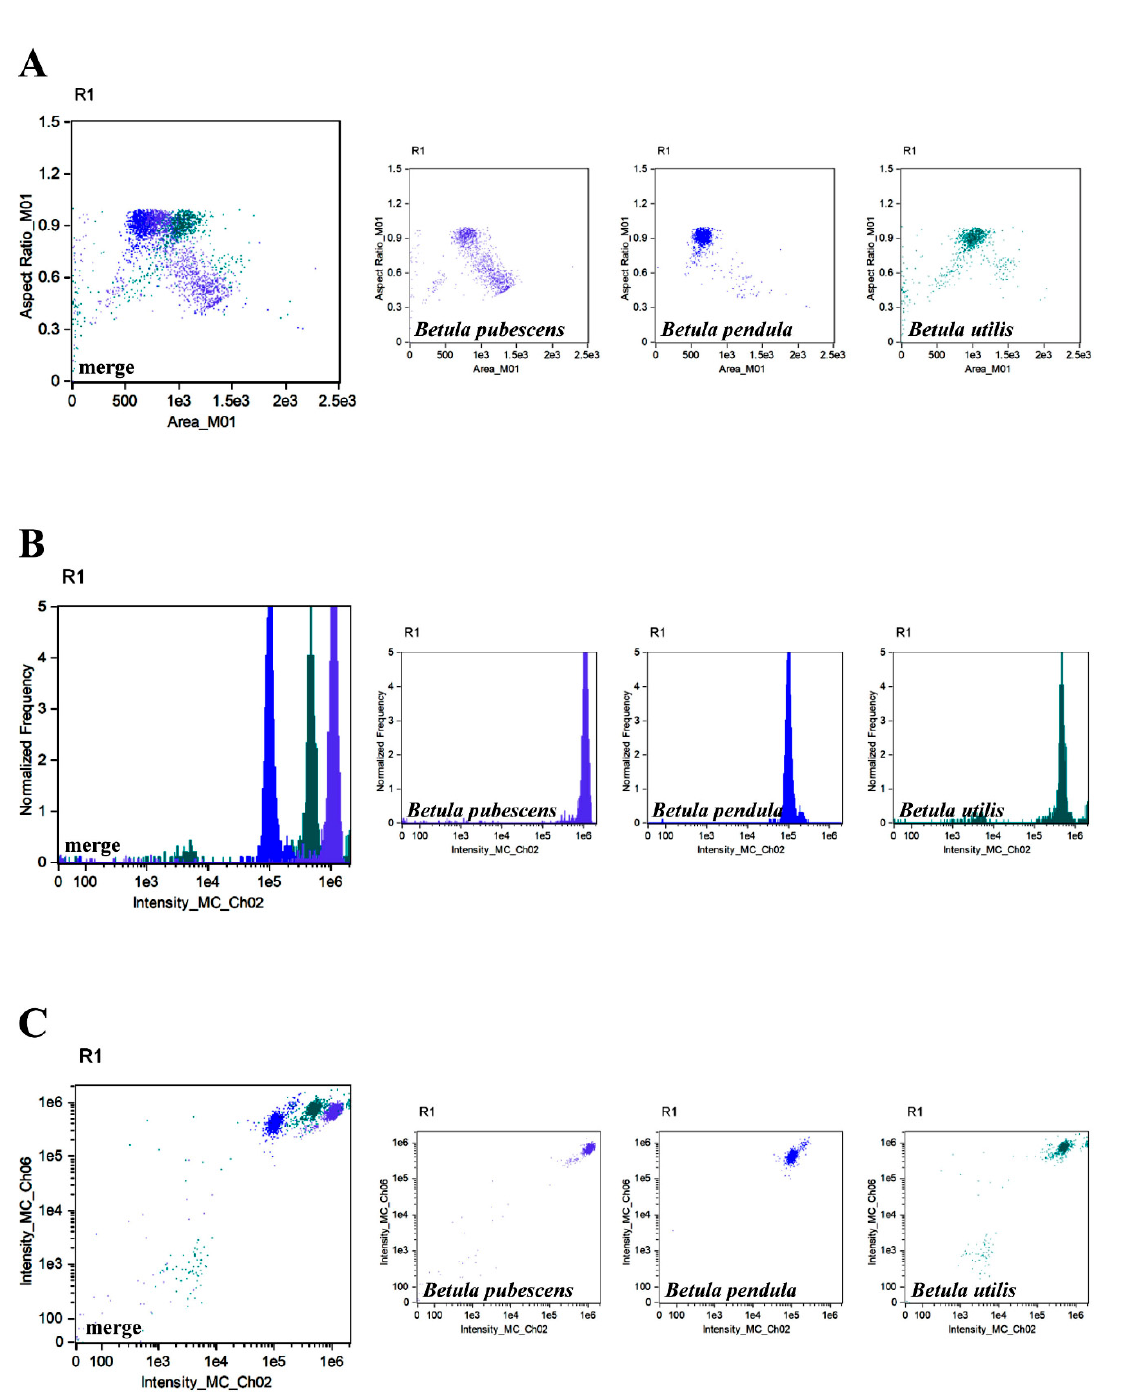
Figure 5. Characterisation of pollen grains populations of three species of birch using IFC. Three types of analysis (different parameters) were considered, namely the parameter ‘aspect ratio’ in channel 1 (BF, y -axis) versus the parameter ‘area’ (channel 1, BF, axis x ) ( A ), ‘normalized frequency’ parameter (channel 1, BF, y -axis) versus fluorescence ‘intensity’ parameter in channel 2 ( x -axis) ( B ) and the ‘intensity’ fluorescence parameter (channel 6, SSC, y -axis) versus fluorescence ‘intensity’ parameter (channel 2, x -axis) ( C ). Betula pubescens (violet), Betula pendula (navy blue), and Betula utilis (teal) separate profiles and merged profiles are shown. Colocalisation analysis allows differentiation of birch at the species level.